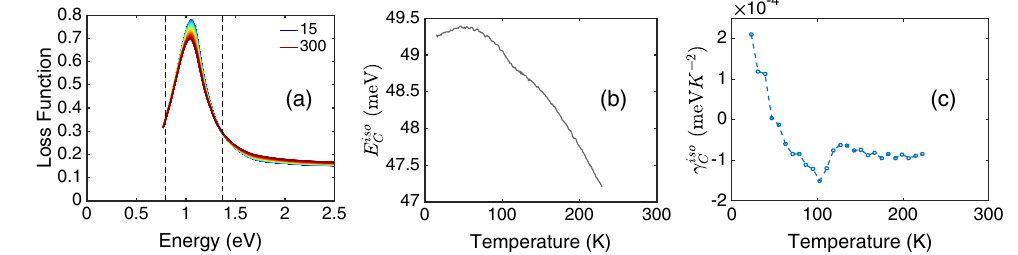
FIG. 3. Optimally doped Bi2223. (a) Loss-function spectra, (b) temperature dependence of the integrated intensity E iso and (c) temperature dependence of γ iso